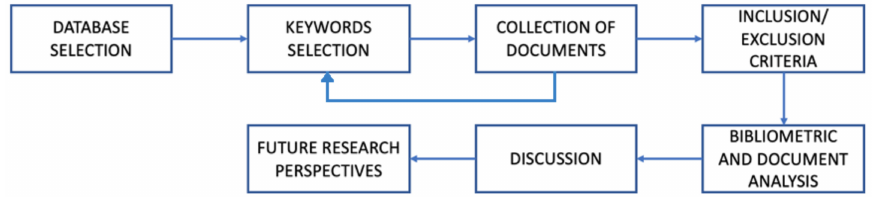
Figure 1. Seven-step procedure for systematic literature